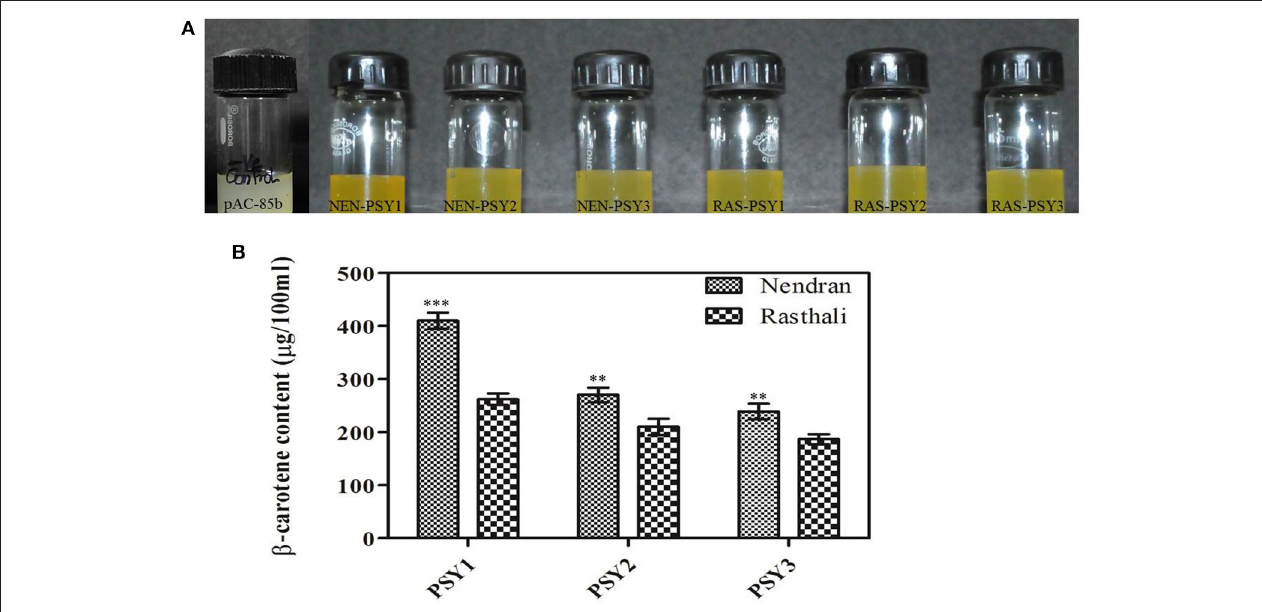
FIGURE 7 | Functional complementation analysis. (A) Color phenotype of E. coli cultures consisting of pAC-85b (control) and complemented with plasmids containing PSY homologs ( NEN-PSY1-3 and RAS-PSY1-3 ). (B) Concentration of β -carotene in E. coli cells after complementation with plasmids pAC-85b and pTrc containing PSY1-3 of Nendran and Rasthali. Bars denote mean of β -carotene content ± SD. Statistical significance was checked at P ≤ 0.05–0.001 (** significant; *** highly significant) with respect to the Rasthali (PSY1-3).